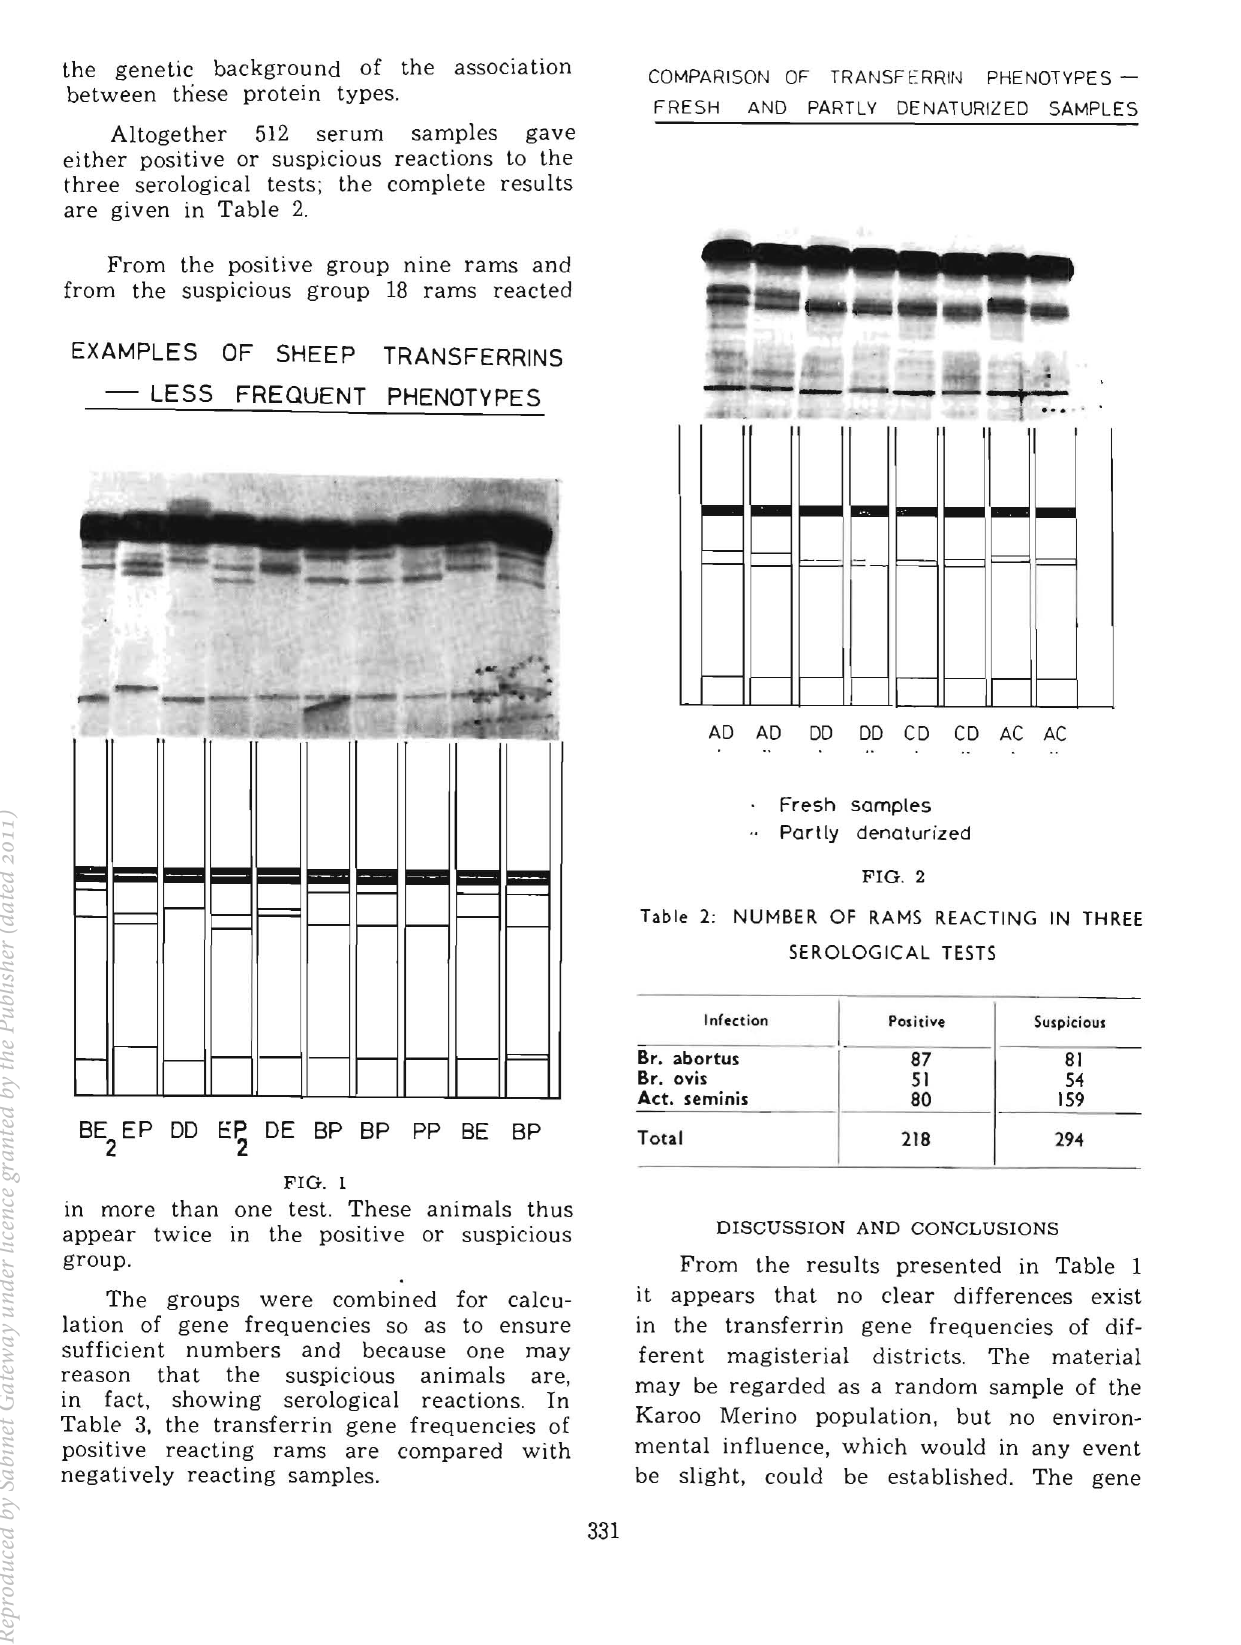
Table 2: NUMBER OF RAMS REACTING IN